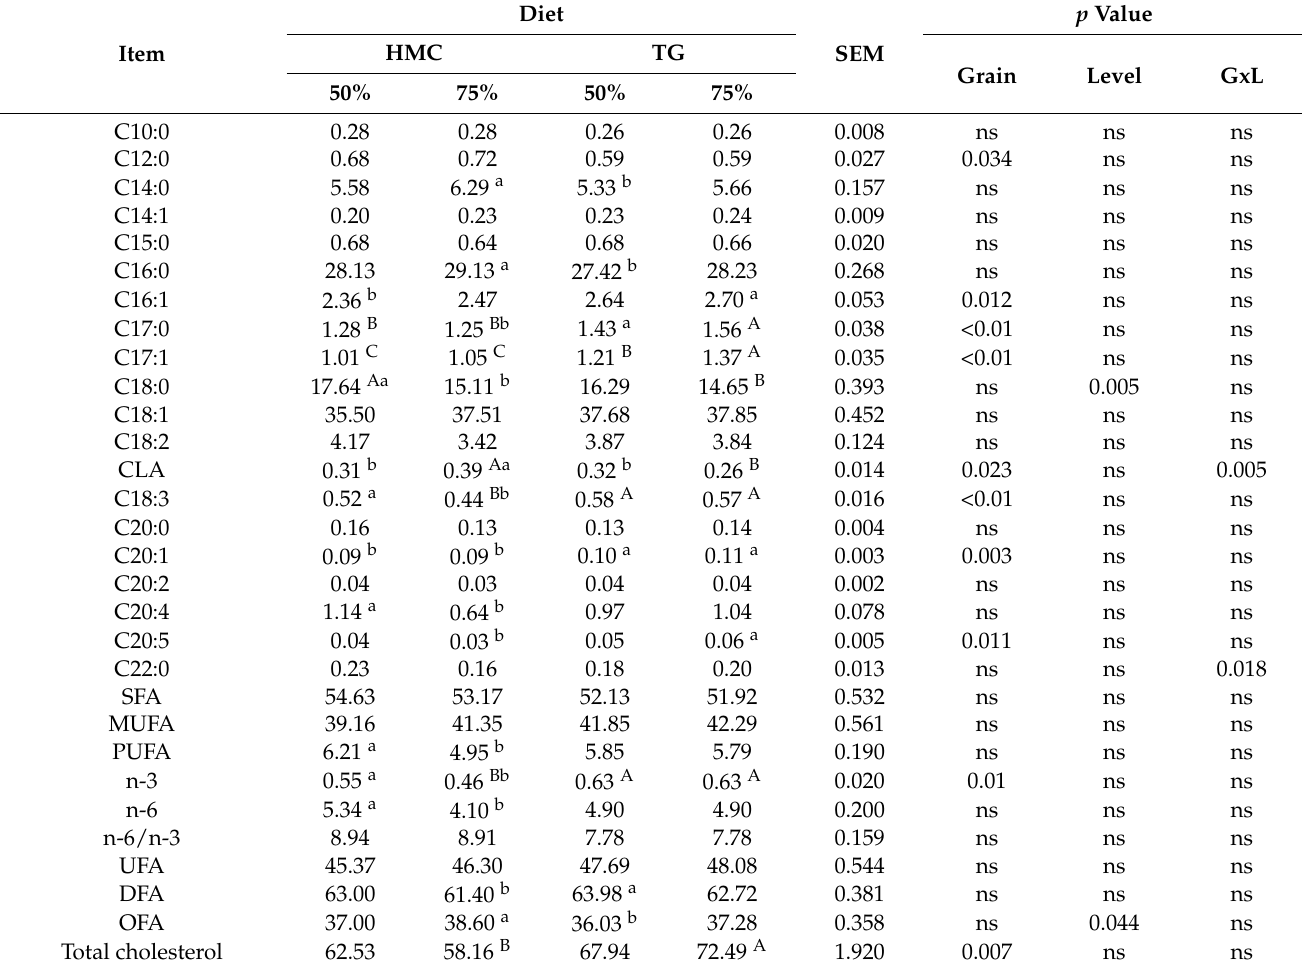
Table 5. Content of fatty acids (% of total fatty acids) and total cholesterol in the leg muscle of